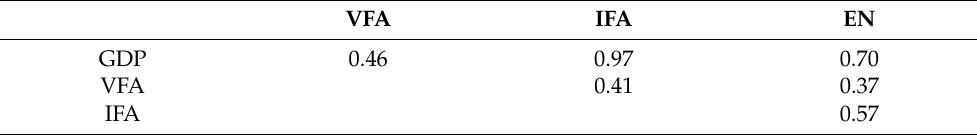
Table 1. Values of the square of the Pearson correlation coefficient between GDP and production factors.